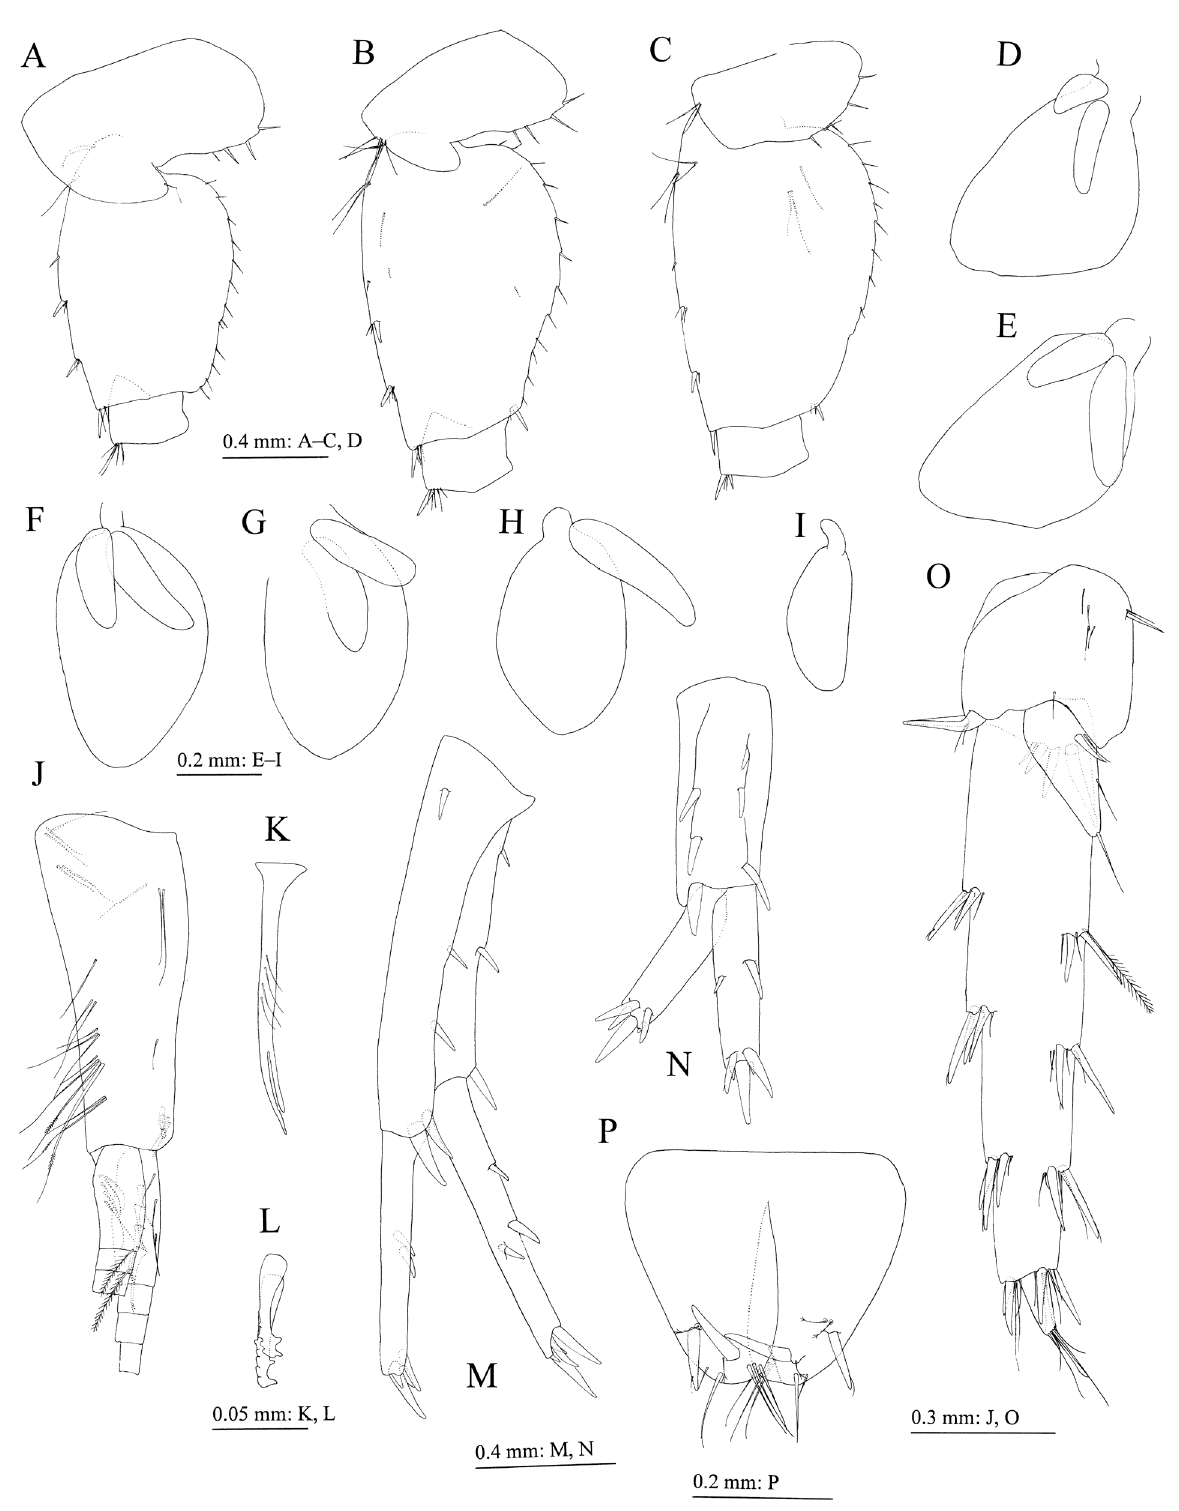
Figure 5. Jesogammarus bousfieldi sp. n., holotype, male (9.8 mm), NSMT-Cr 25470 (A–C and E–P) and paratype, female (6.6 mm), NSMT-Cr 25471 (D). A coxa–ischium of pereopod 5, lateral view; B coxa–ischium of pereopod 6, lateral view; C coxa–is- chium of pereopod 7, lateral view; D–I coxal gills on gnathopod 2 and pereopods 3–7, lateral views; J pleopod 1, lateral view, distal parts of rami omitted; K bifid plumose seta (clothes-pin seta) on inner basal margin of inner ramus of pleopod 1, lateral view; L retinacula on peduncle of pleopod 1, lateral view; M uropod 1, dorsal view; N uropod 2, dorsal view; O uropod 3, dorsal view; P telson, dorsal